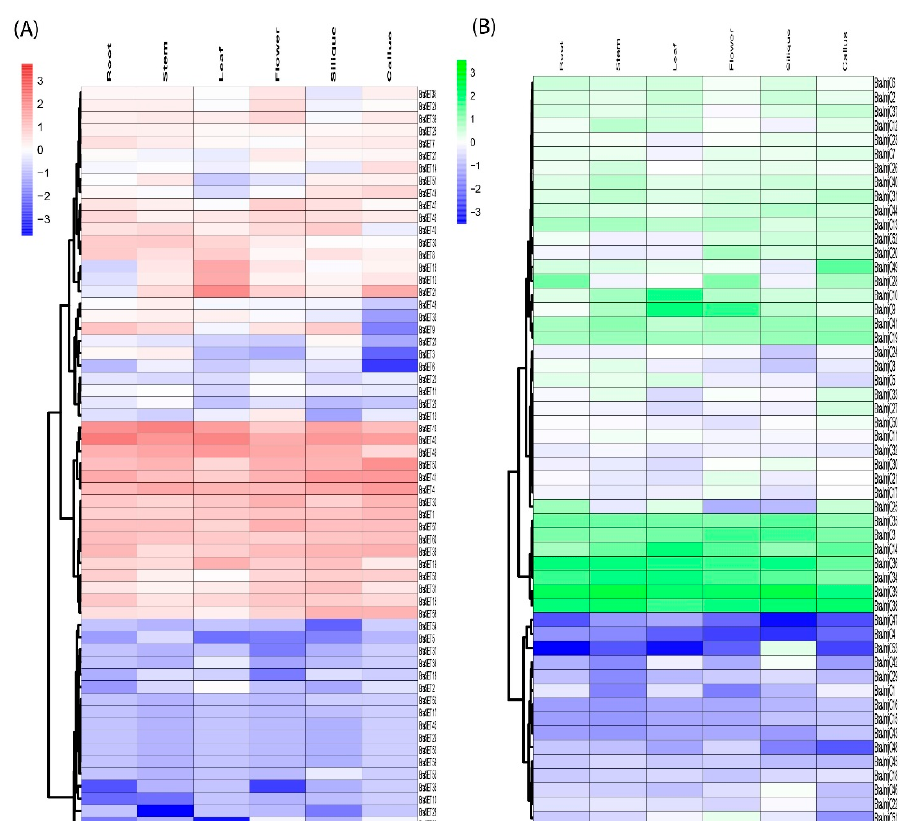
Figure 5. Heat map of expression profiles (log 2 fold-change) for SET ( A ) and JmjC ( B ) in the six various tissues: stem, flower, callus, silique, root, and leaf. The expression levels are indicated by the color bar.